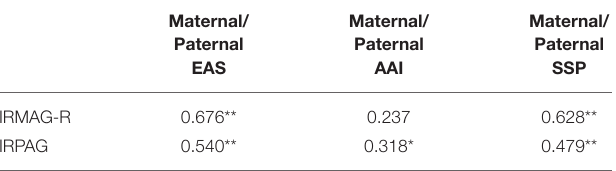
TABLE 3 | Correlations of IRMAG-R and IRPAG with criteria.